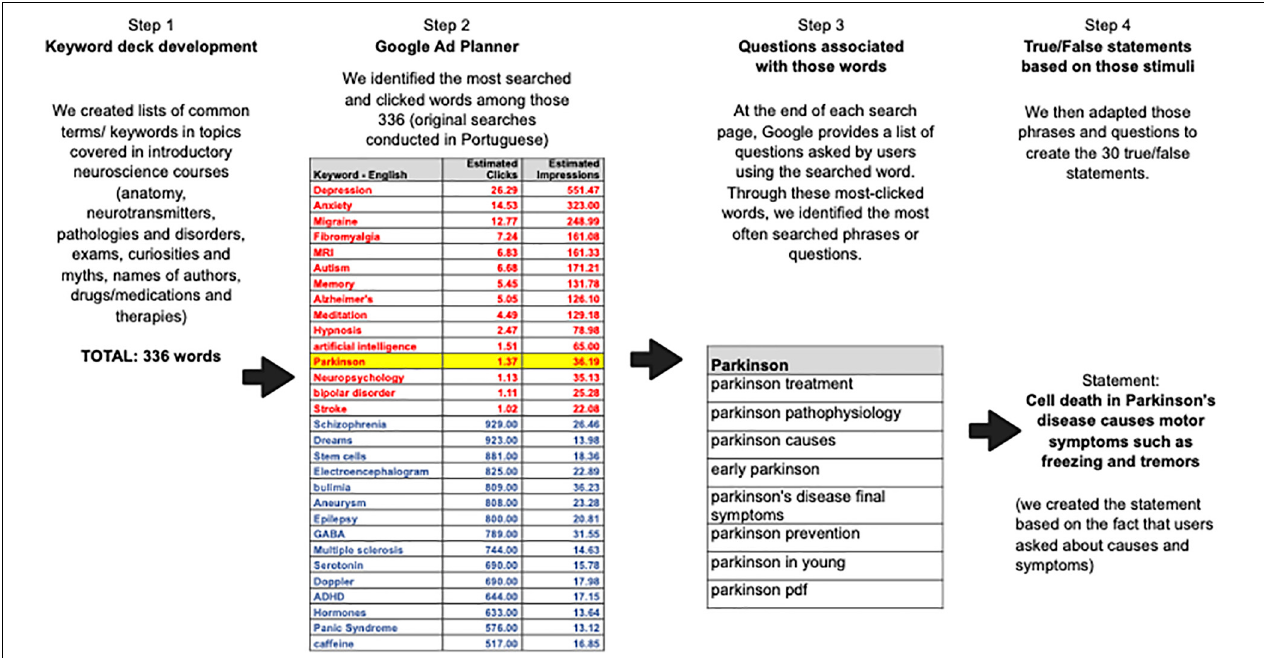
FIGURE 1 | Flowchart showing the steps taken to create the